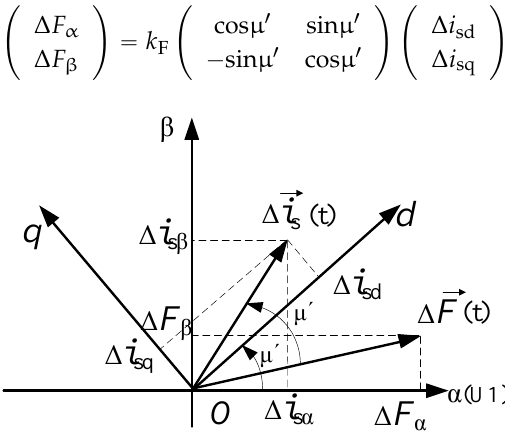
Figure 8. Transformation of the suspension current components and suspension force.